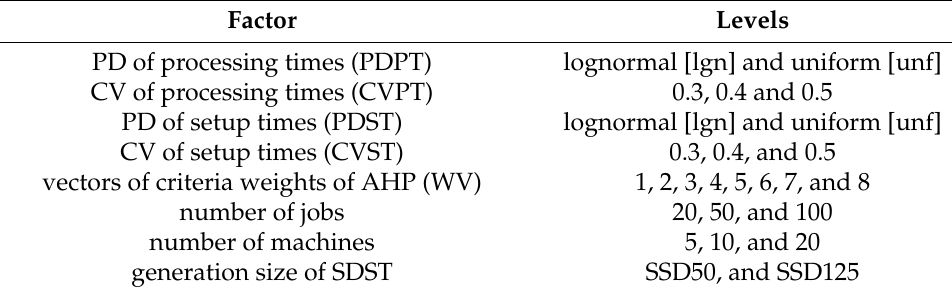
Table 7. Factors of the experimental design and their corresponding